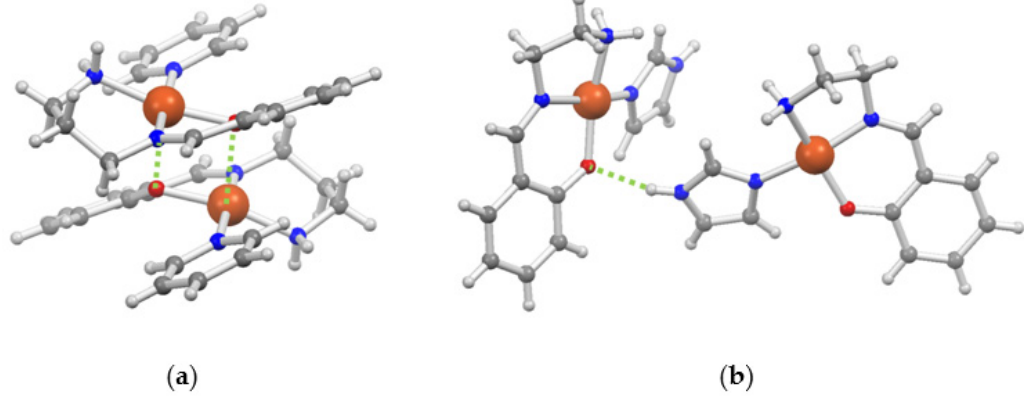
Figure 2. Molecular structures of two mononuclear copper(II) complexes with tridentate N 2 O Schiff base ligands: ( a ) [Cu( H L)(py)](ClO 4 ) ( H L – from H-salH and tn, dimeric assembly of two cationic species through short Cu ··· O interactions, dashed green lines), CSD/CCDC VOGTOB/684254 [39], and ( b ) [Cu( H L)(imH)](ClO 4 ) ( H L – from H-salH and en, N–H ··· O intermolecular hydrogen bond between two cations in dashed green line), CSD/CCDC SIFZOW/1258852 [66]. Reproduction of the structures with Mercury ® 4.3.1 software [71], color code: Cu = orange, O = red, N = blue, C = gray, H = white, perchlorate anions omitted for